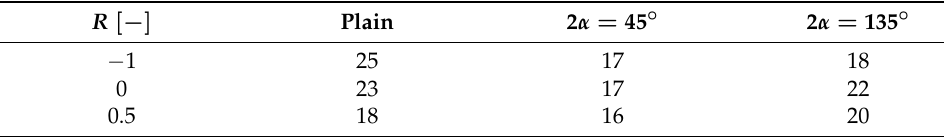
Table 2. Number of tested specimens of each specimen geometry. R [ − ]